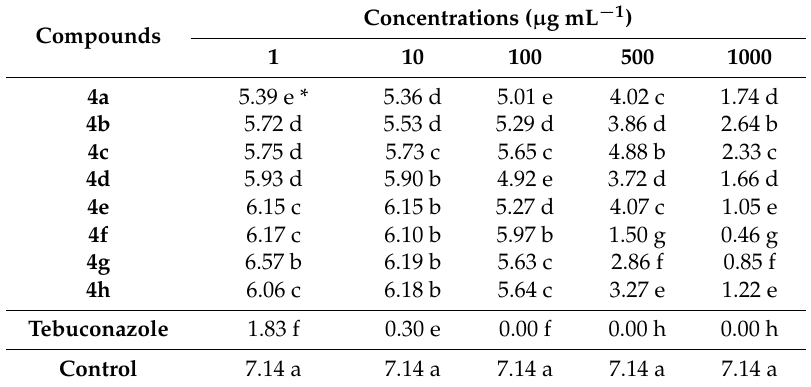
Table 1. Mean values for mycelial growth (cm) of Colletotrichum gloeosporioides treated with triazoles ( 4a – 4h ).